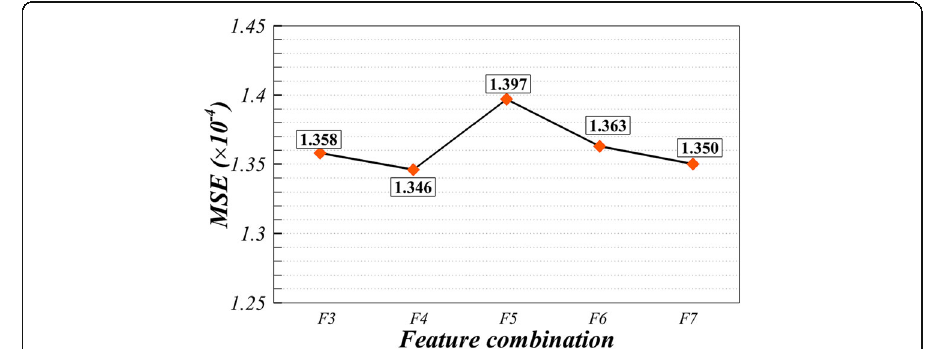
Fig. 8 The model performance based on different feature